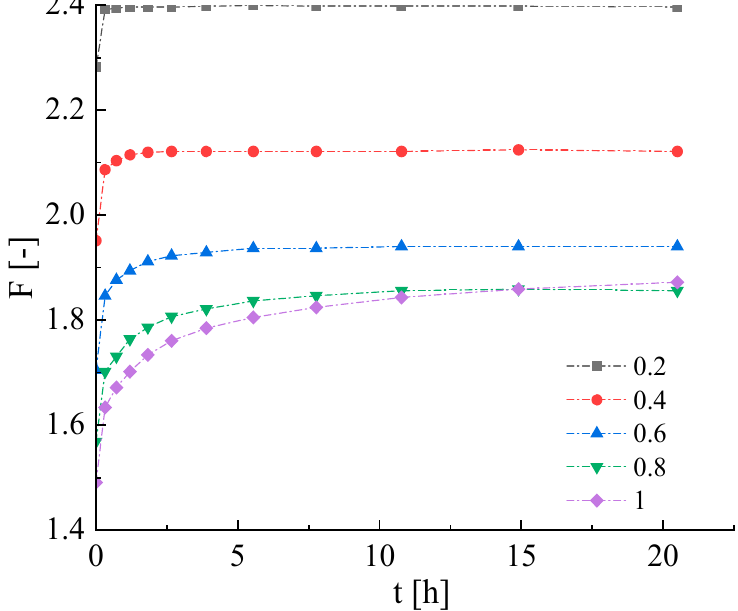
Figure 10. Changes in slope stability with time for different drop ratios after the water level stabi- lizes.